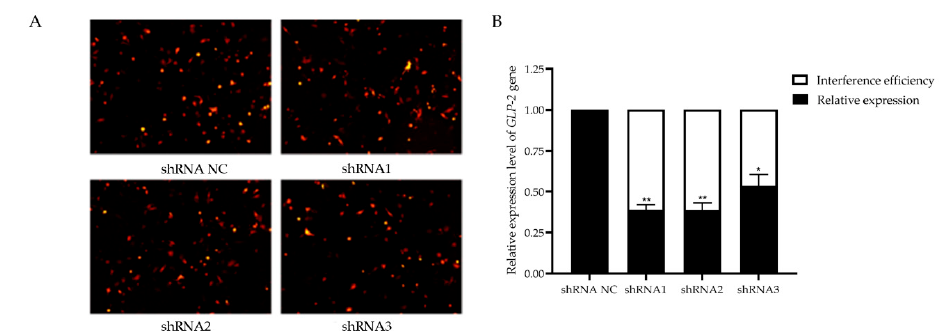
Figure 4. Verification of GLP-2 gene interference efficiency. ( A ) Transfection of GLP-2 gene shRNAs vector into IPEC-J2 cells. ( B ) GLP-2 gene mRNA expression level. shRNA NC represents negative control. shRNA1 shRNA2 and shRNA3 represent three RNA interference fragments of the GLP-2 gene. * p < 0.05, ** p < 0.01. Bars represent the mean ± SD ( n = 3).